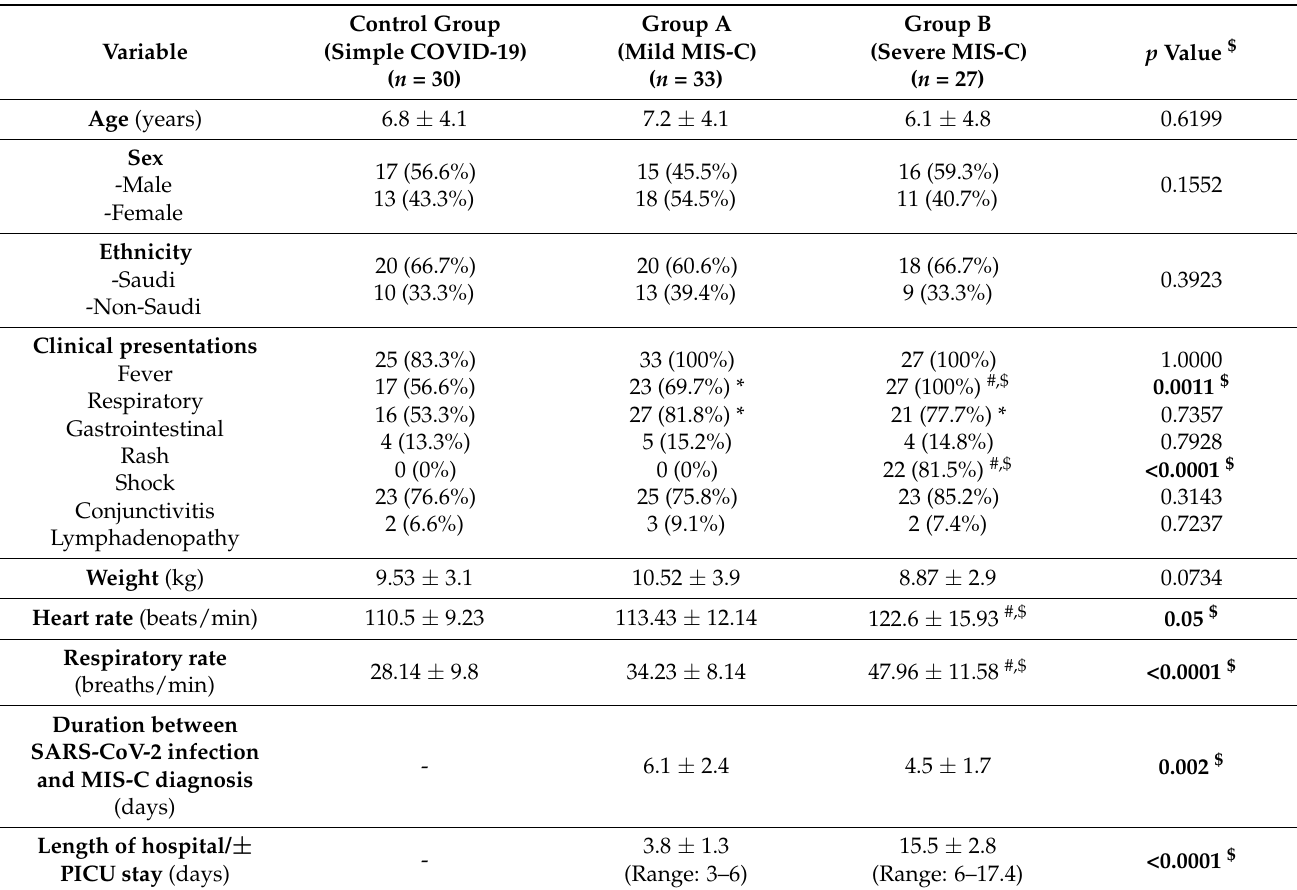
Table 1. Demographics, clinical presentations, and basic laboratory workup of the study cohort and controls at Day 1 of